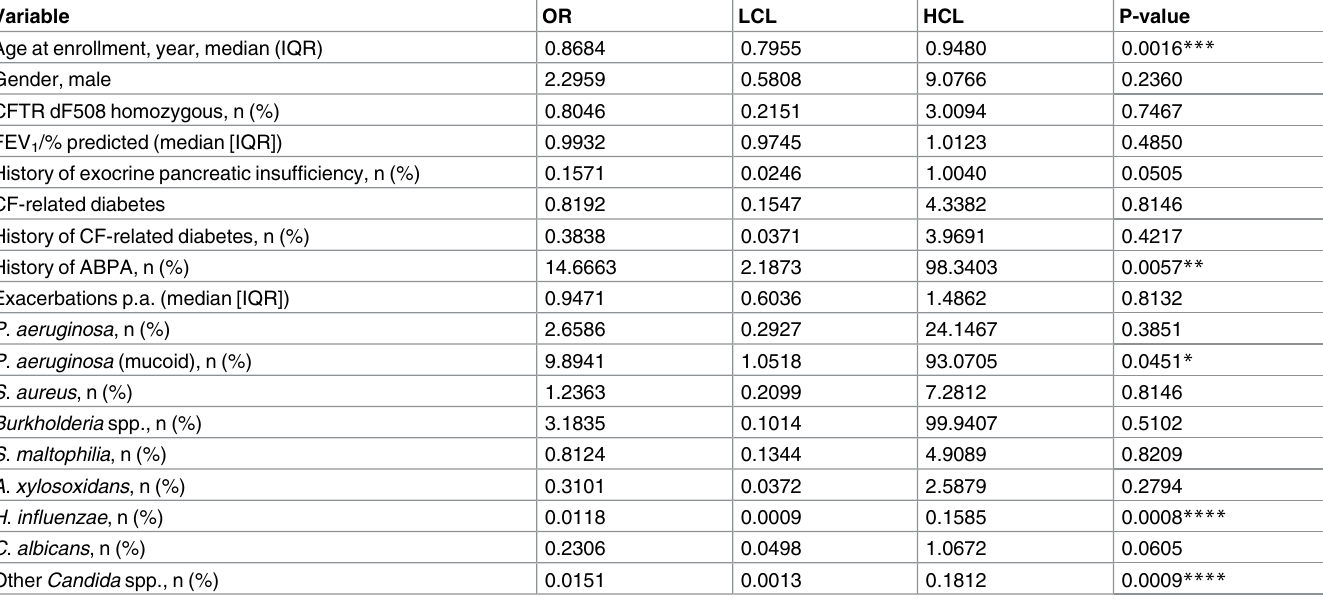
Table 3. Adjusted odds ratios for association factors for Scedo colonization (total n =